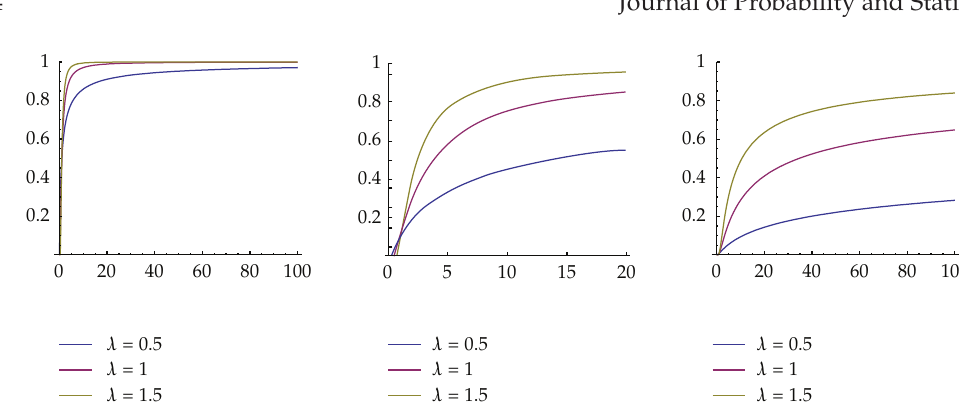
Figure 2: Graph of c.d.f. of inid o.s. from Ef distribution for selected values of α 1 (cid:6) 0 . 03; α 2 (cid:6) 0 . 05; α 3 (cid:6) 0 . 07; σ